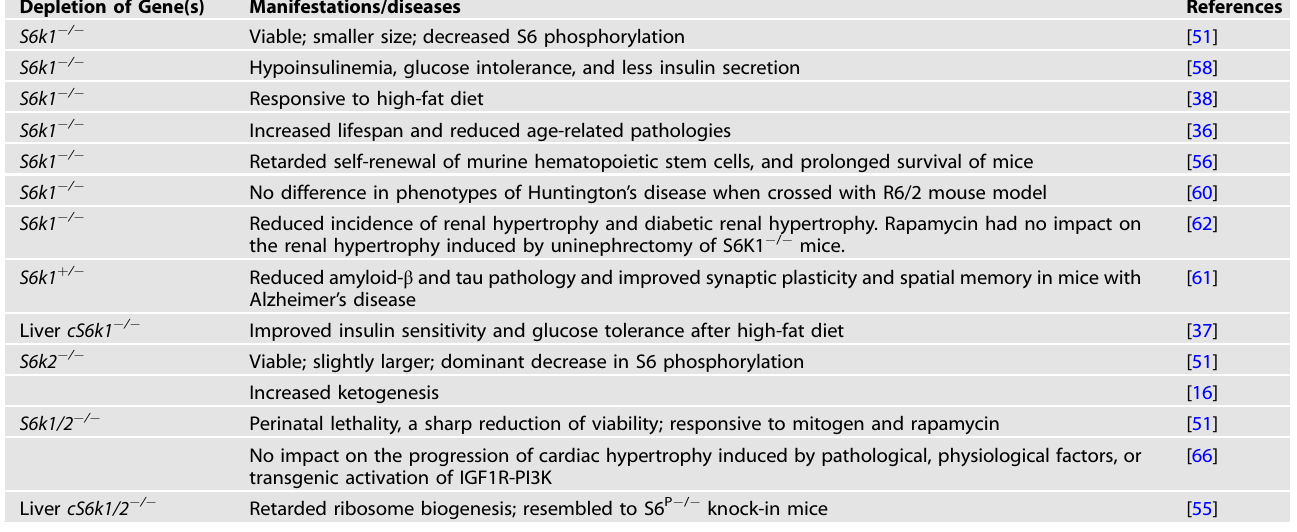
Table 1. Genetic mouse models for S6K